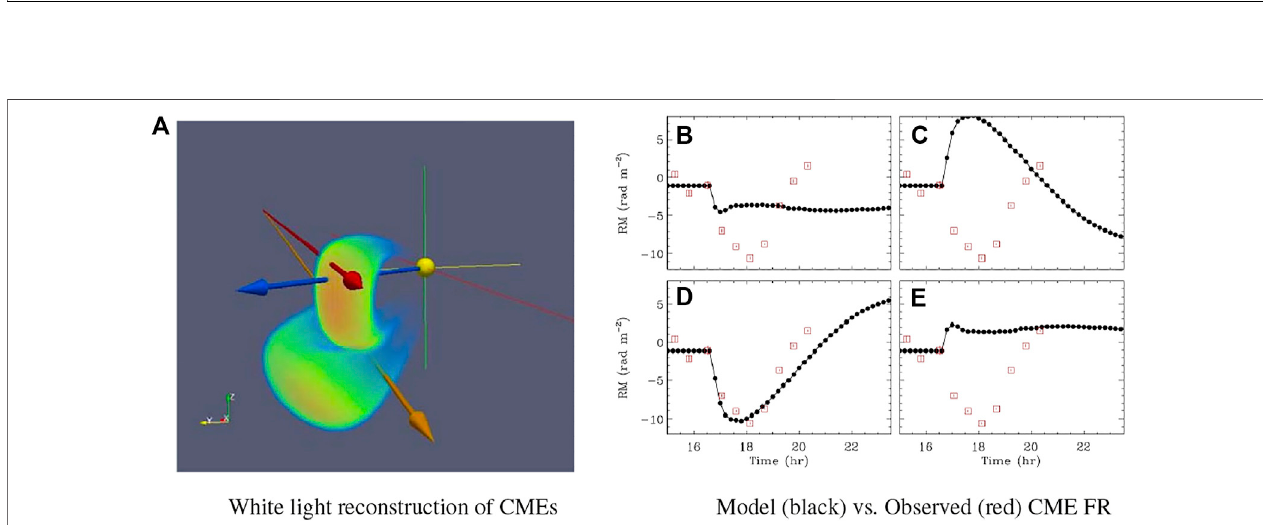
FIGURE 9 | Reconstructed 3D magnetic fl ux rope structures of two CMEs that erupted off the western limb of the Sun given in heliocentric Earth ecliptic (HEE) coordinates (A) andthemodelFR(blackdata)forthefourpossiblemagnetic fi eldorientationscorrespondingtothesouthernCMEinpanels (B – E) .Thebluearrowpoints from the Sun in the direction of STEREO-A , which was impacted by the northern CME. The red and orange arrows point from the Earth in the direction of background radio sources used in FR observations reported in Kooi et al. (2017). The axes are color-coded to match the HEE coordinate axes in the bottom-left corner. In panels (B – E) , the FR measurements (red data) clearly favor the magnetic fi eld orientation in (D) . The left panel and right panels appear as Figures 4, 10, respectively, in Wood et al. (2020), ©AAS, reproduced with permission.